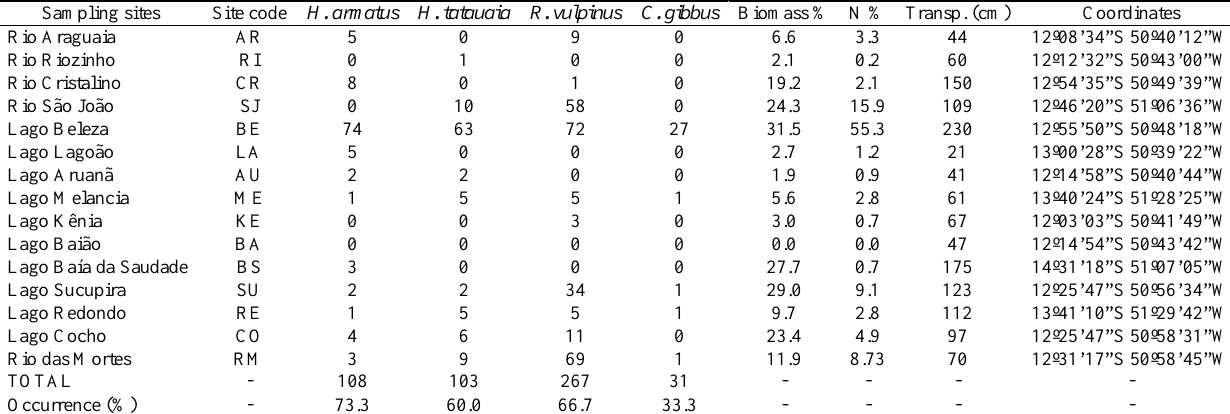
Table 1. Abundance and frequency of occurrence for Cynodontidae species, and relative abundance in biomass and number of individuals (N) for each sampling site in the Bananal floodplain. Water transparency and coordinates are also indicated for each site.